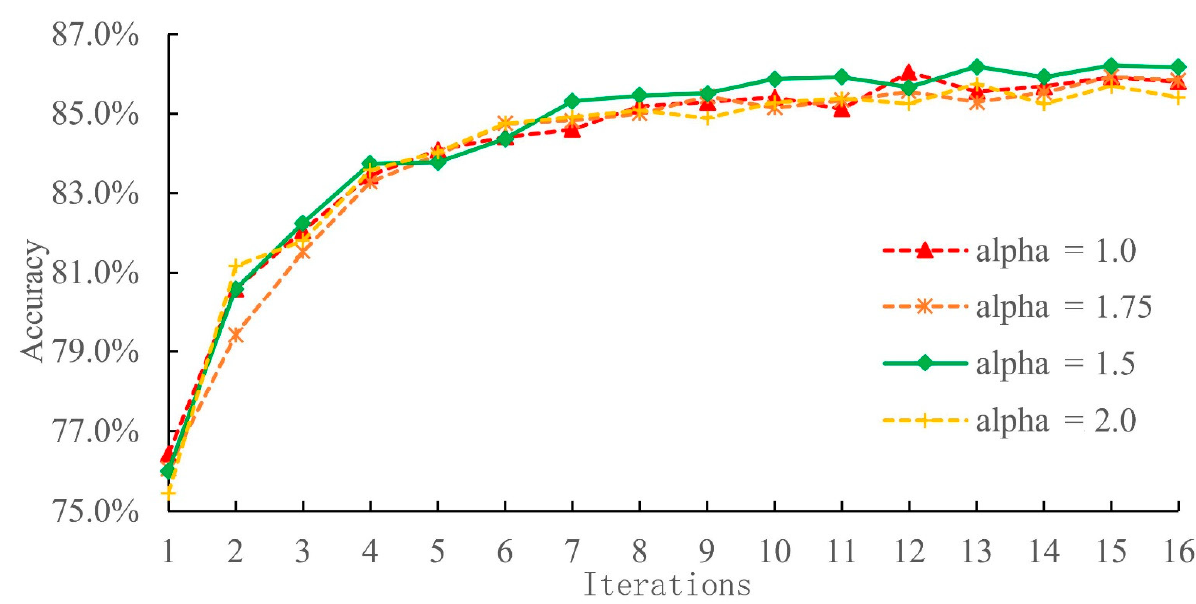
Figure 8. The learning curve of different alpha.